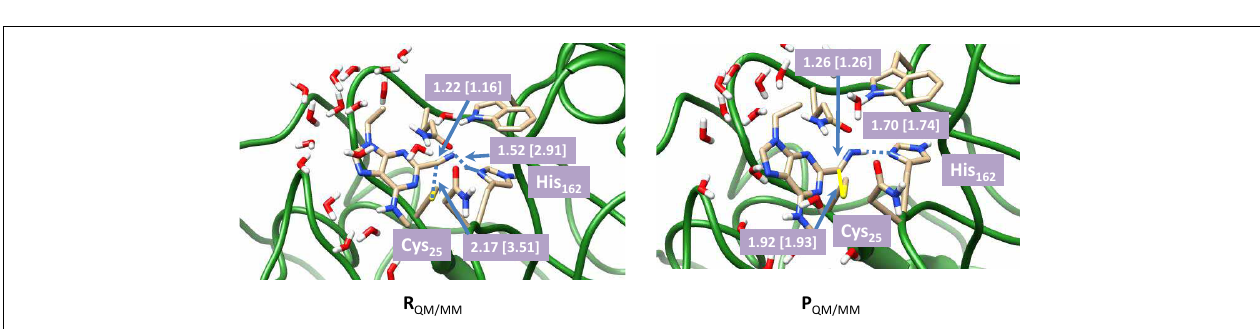
FIGURE 4 | Optimized geometries with bond lengths in angstroms of reactant and product geometries for nitrile-based inhibitors of cathepsin K as calculated with QM(B3LYP/6-311G)/MM. Data in square brackets were obtained with electronic embedding included.